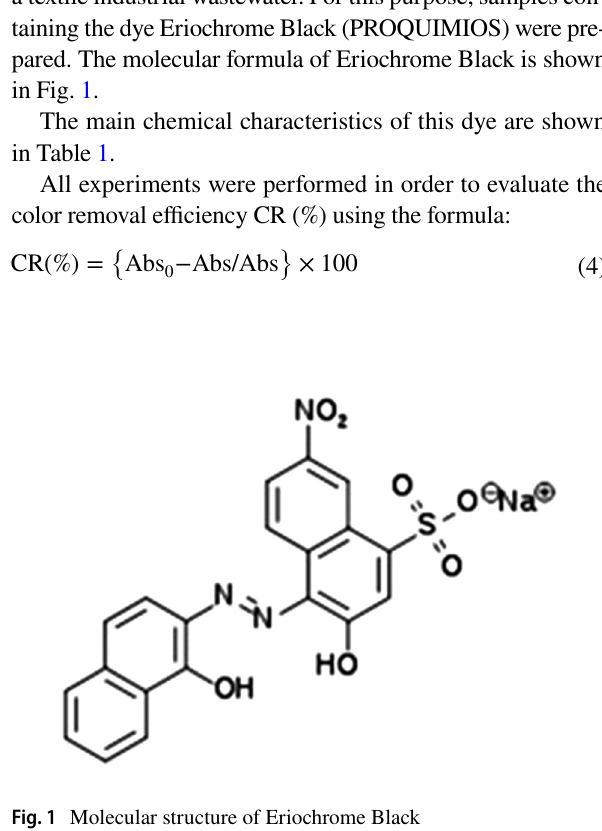
Fig. 1 Molecular structure of Eriochrome Black